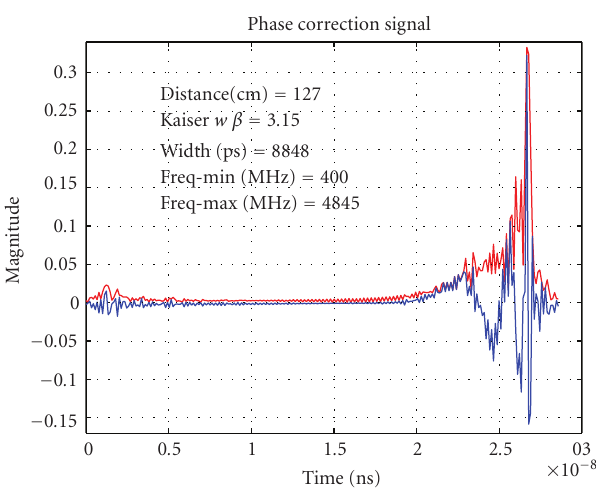
Figure 8: Phase correction signal in time domain (red line: absolute values, blue line: real values).